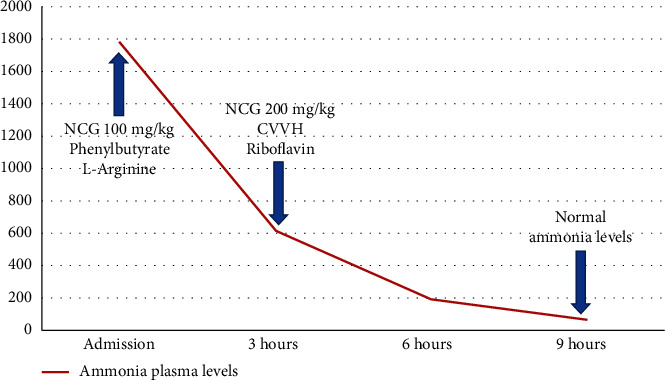
Evolution of ammonia levels (μmol/L) during the neonatal decompensation.